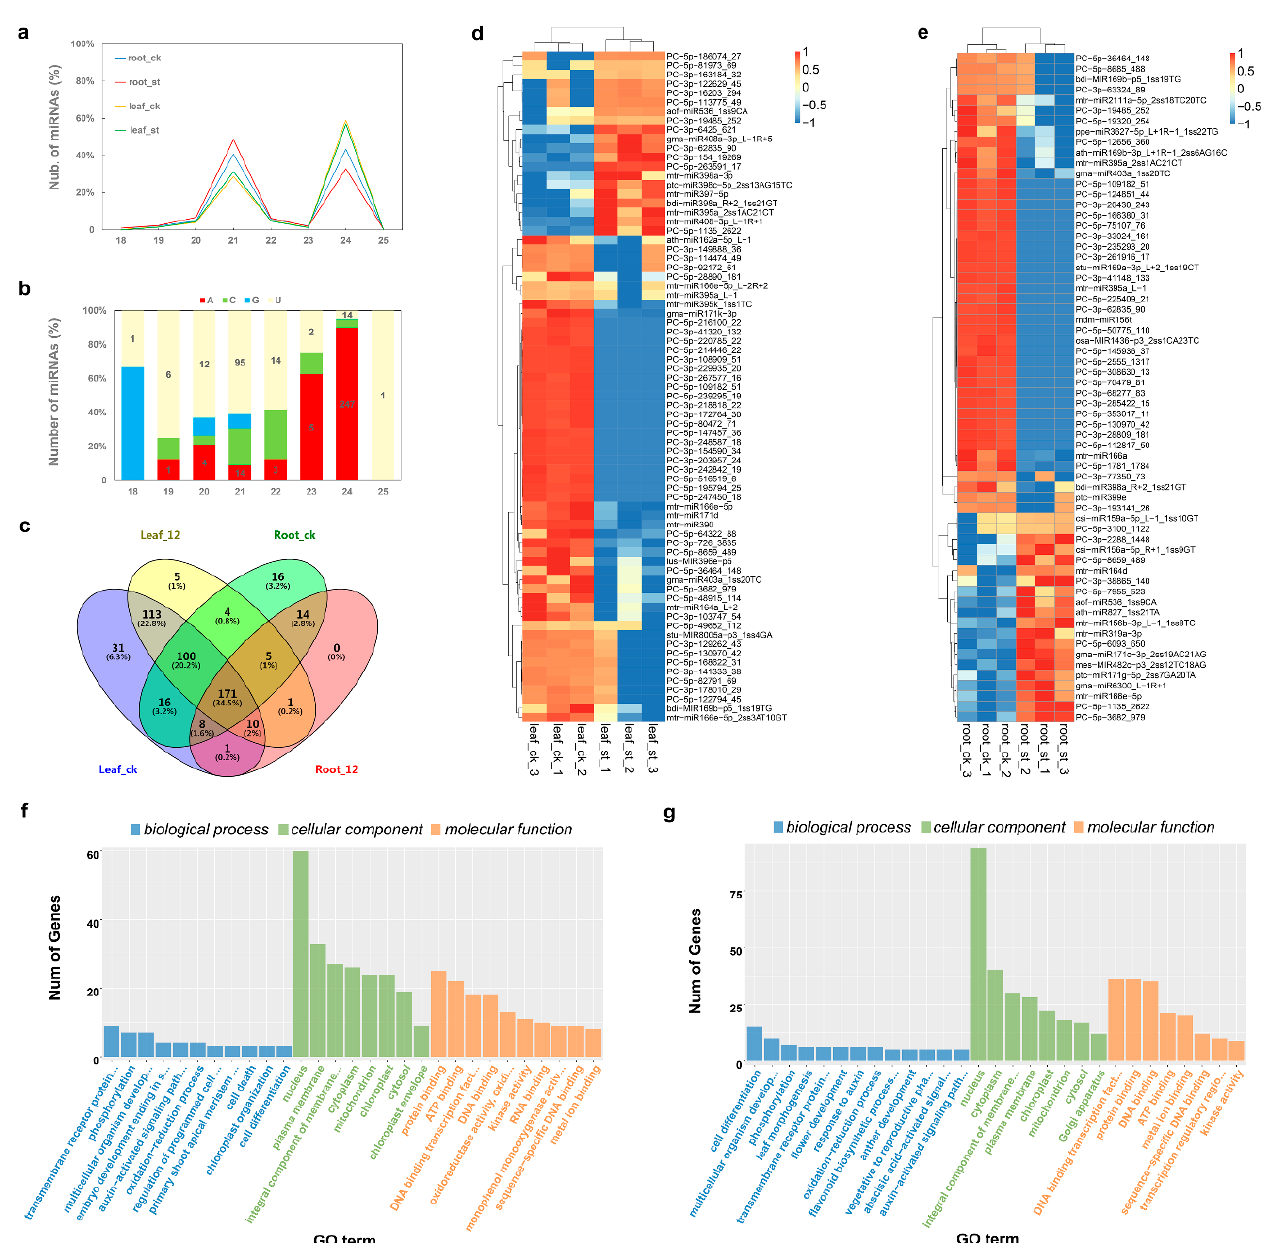
Figure 4. Identification and analysis of DEmiRNAs under salt stress. ( a , b ) Identified miRNAs length distribution ( a ) and 5 ′ nucleotide composition ( b ). ( c ) Venn diagram of identified miRNAs in each sample. ( d , e ) Heat map of DEmiRNAs in leaves ( d ) and in roots ( e ). ( f , g ) GO annotation of targets of DEmiRNAs in leaves ( f ) and in roots ( g ).